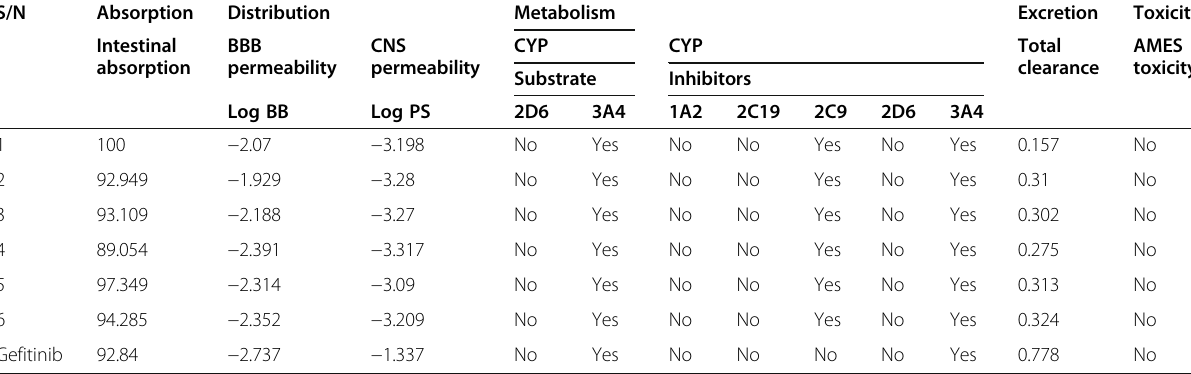
Table 4 ADMET properties of newly designed EGFR inhibitors S/N